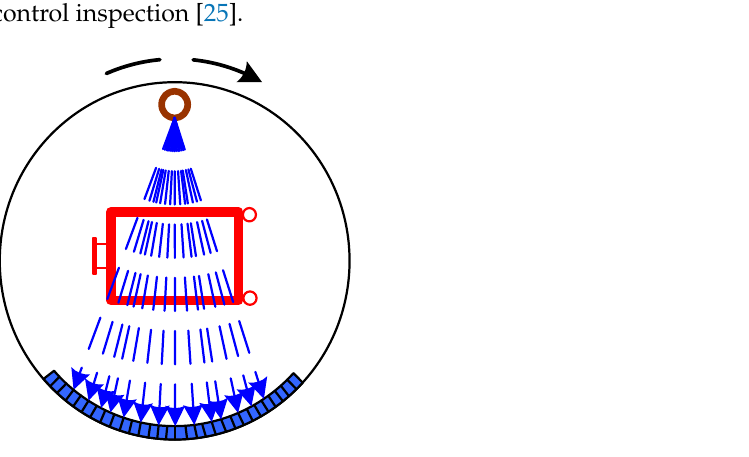
Figure 3. Schematic representation of a Real-Time Computed Tomography